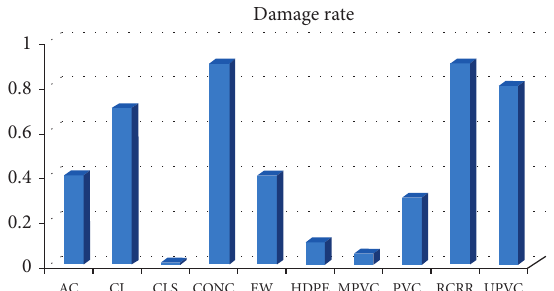
Figure 3: Demolition rate of pipelines considering their type in the New Zealand